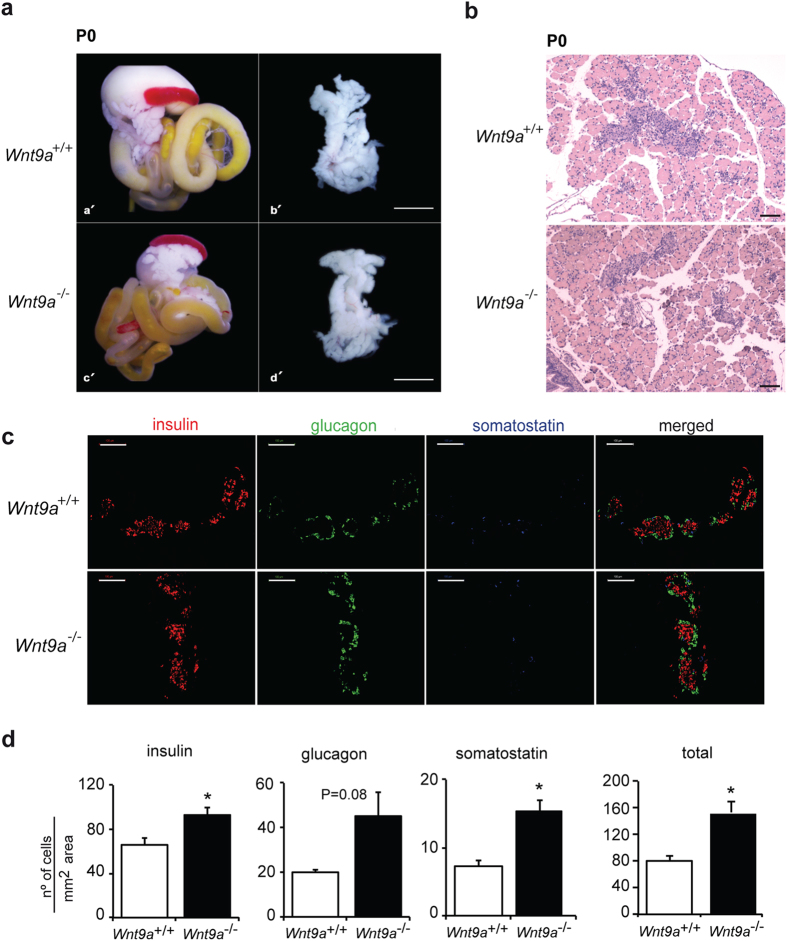
Pancreatic phenotype of Wnt9a knockout embryos.(a) Examination of gross morphology of digestive tract (a’,c’) and pancreas (b’,d’) from neonatal Wnt9a+/+ (a’,b’) and Wnt9a−/− (c’,d’) mice. Scale bar is 5000 μm. (b) Hematoxylin and Eosin staining was performed on paraffin sections from pancreatic tissue from neonatal Wnt9a+/+ and Wnt9a−/− mice. Scale bar is 200 μm. (c) Staining for insulin (red), glucagon (green) and somatostatin (blue) on paraffin sections from pancreases of E18.5 Wnt9a+/+ and Wnt9a−/− embryos. Scale bars represent 100 μm. (d) Morphometric quantification of the number of endocrine cells per pancreatic area in E18.5 Wnt9a+/+ and Wnt9a−/− embryos. Positive cells for each indicated hormone were counted separately and for the number of total endocrine cells combined (total). Bars represent mean ± SEM from 5 animals per genotype. *p < 0.05 vs Wnt9a+/+.